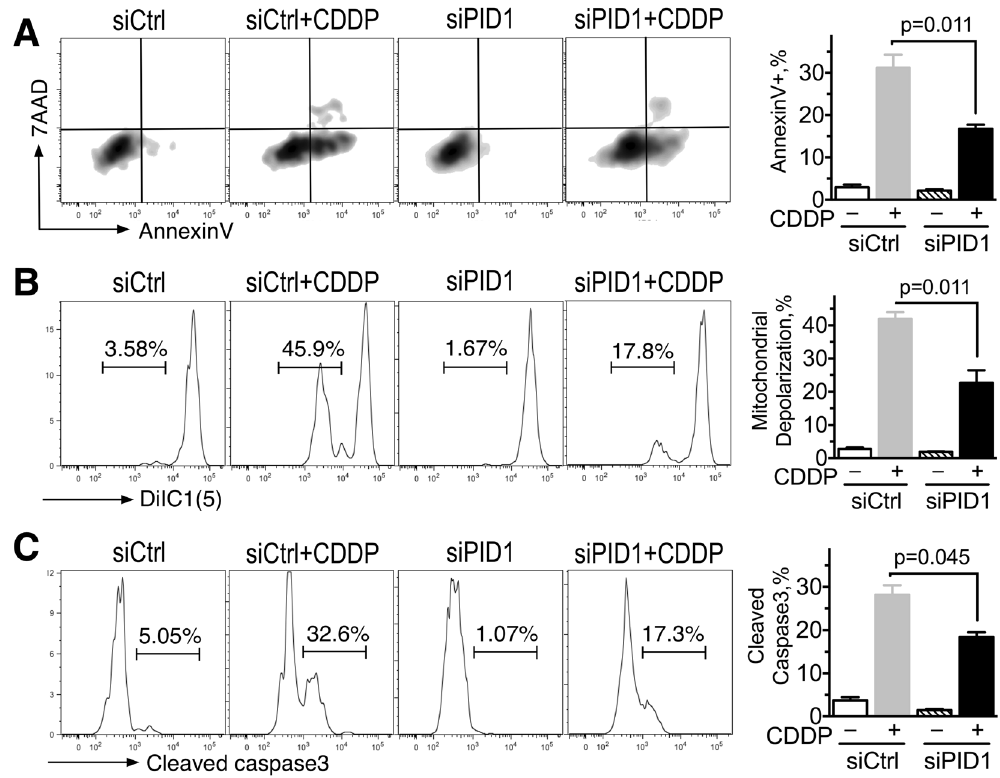
Figure 2. Knockdown of PID1 diminishes apoptosis induced by cisplatin. UW228 cells (4 × 10 5 per well) were transfected with non-silencing control siRNA (siCtrl) or PID1 siRNA (siPID1) and FAM-labeled non- silencing siRNA to label transfected cells. Twenty-four hrs after transfection cells were treated with 10 µ g/ml cisplatin for 24 hrs, and apoptosis (AnnexinV positive ( A ), mitochondrial membrane depolarization (DiIC1(5)) ( B ), or cleaved caspase-3 ( C ) were assessed by flow cytometry in the FAM-labeled cells. A representative flow cytometry curve is on the left and mean ± SEM (n = 3 biological replicates) of one experiment of two with similar results are shown on the right. Western blot of PID1 siRNA knockdown is shown in Supplementary Fig. S3D. Similar effects on mitochondrial membrane depolarization were seen in D283 medulloblastoma and U87 GBM cells (see Supplementary Fig.